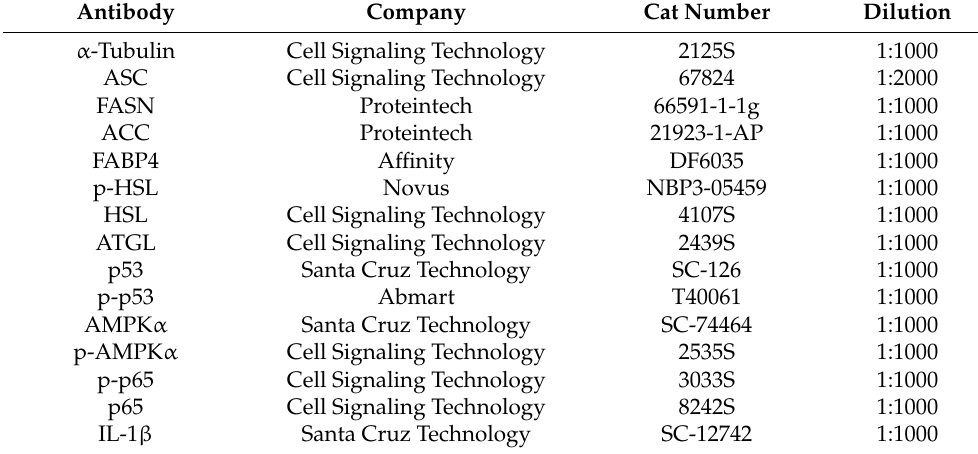
Table 2. Antibodies used in this paper.